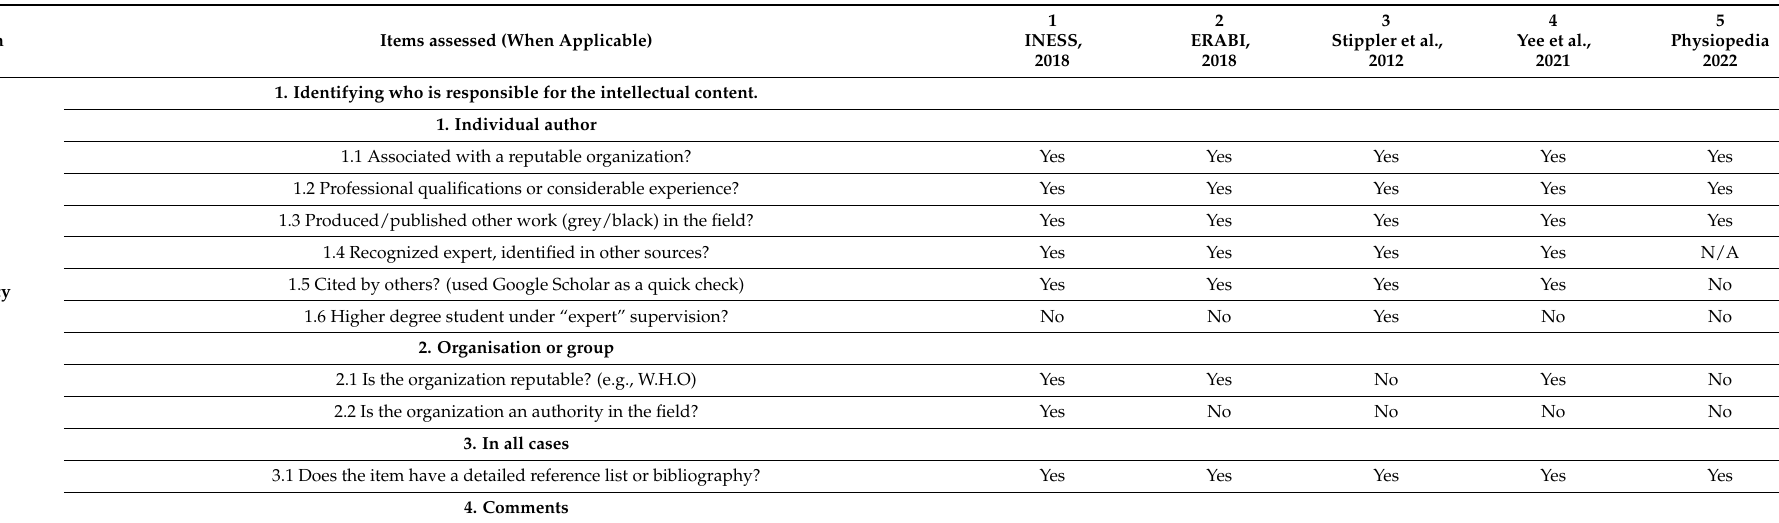
Table A2. Authority, Accuracy, Coverage, Objectivity, Date, Significance (ACCODS) Checklist for Measuring Gray Literature Sources Quality: Summary of included